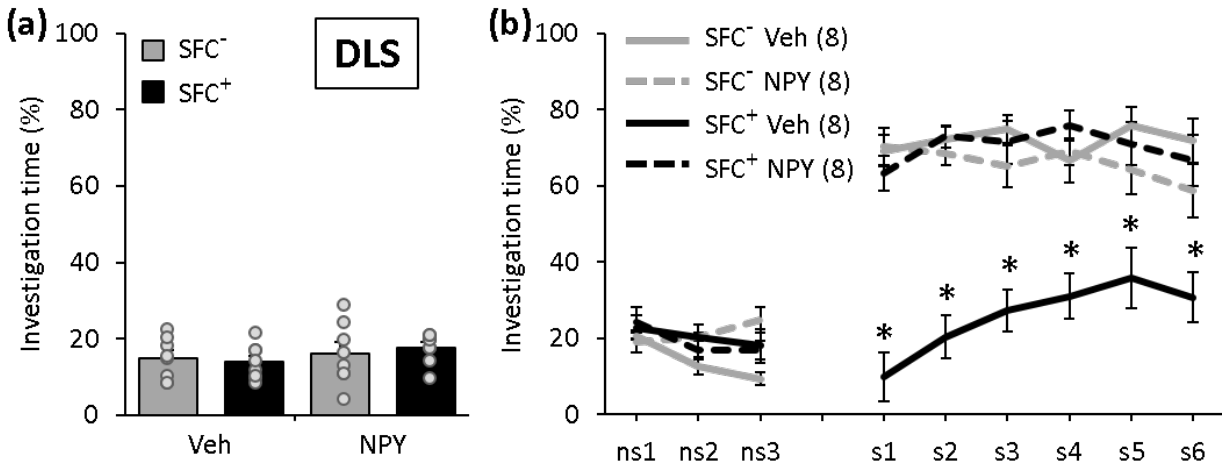
Figure 2. NPY reduces the expression of social fear when administered into the dorsolateral septum (DLS). ( a ) Pre-conditioned investigation of the non-social stimulus (empty cage) during SFC on day 1. ( b ) Investigation of the non-social (ns1–ns3) and social (cages with mice; s1–s6) stimuli during social fear extinction on day 2. Unconditioned (SFC − ) and conditioned (SFC + ) mice were administered either vehicle (Veh; 0.2 µ L/side) or NPY (0.1 nmol/0.2 µ L/side) 10 min before social fear extinction. Data represent means ± SEM and numbers in parentheses indicate group sizes. p < 0.05 * vs. all